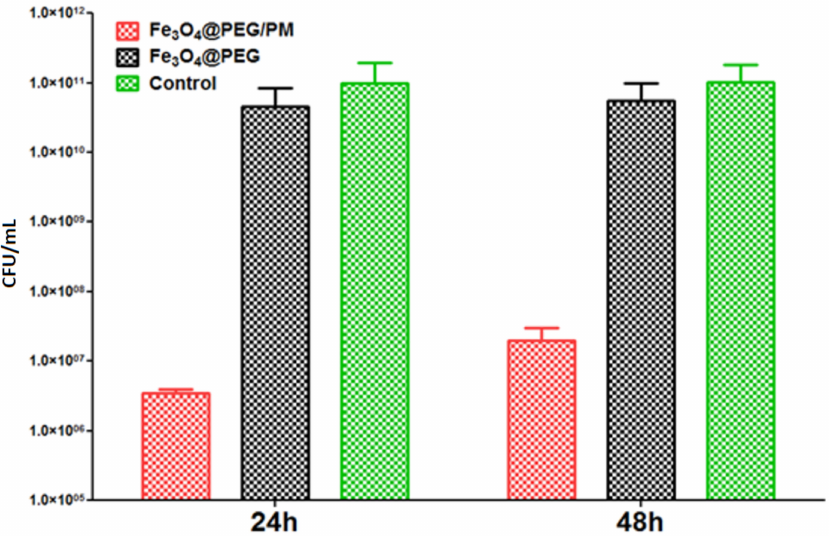
Figure 10. Evaluation of biofilm development after 24 and 48 h of incubation in the presence and absence of PEG-based thin film for P. aeruginosa